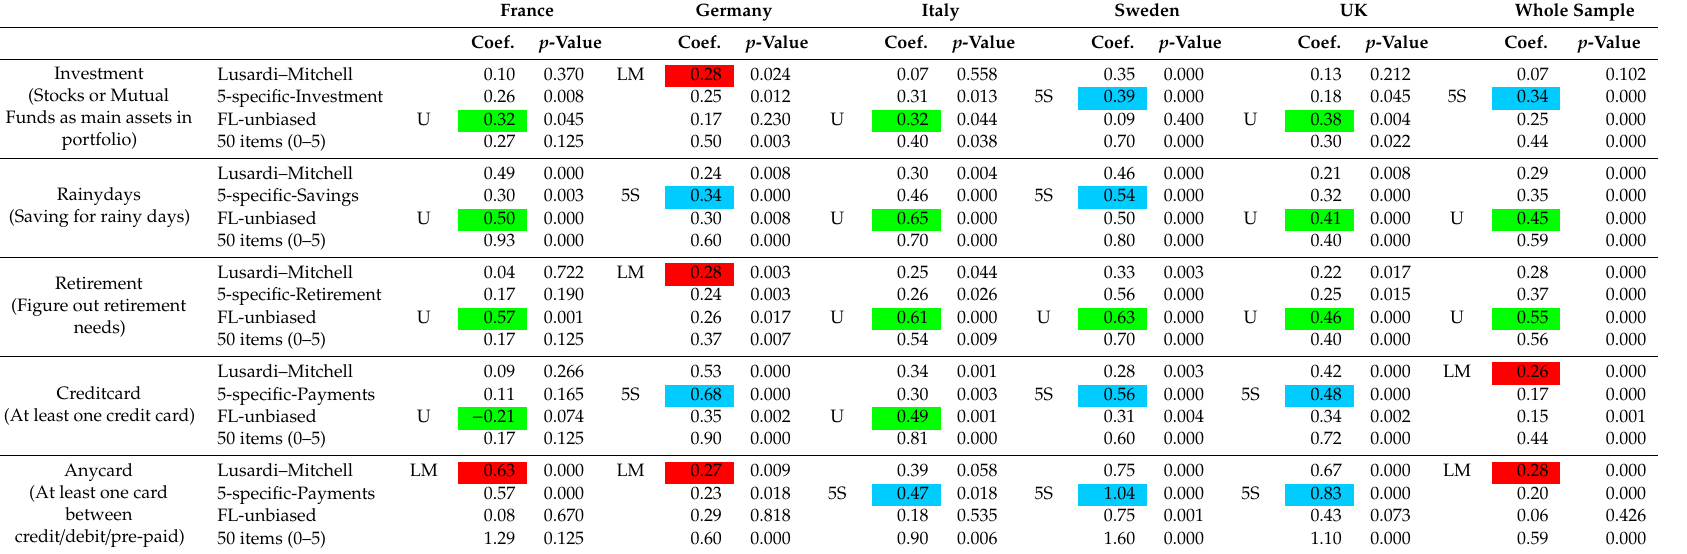
Table 3. The explanatory power of di ff erent financial literacy measures on financial behaviors: empirical